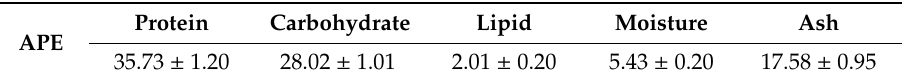
Table 6. Biochemical composition of A. platensis F&M-C256 extract used in the experiments. Data are expressed as % of extract dry